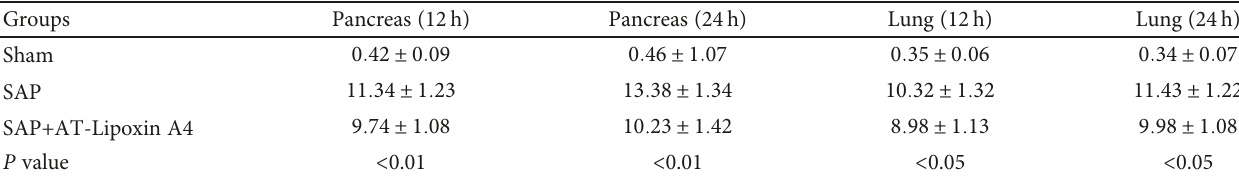
Figure 5: Attenuation of histopathological injury of the pancreas and lung in SAP model by AT-Lipoxin A4 administration. (a – f) H&E staining shows changes of the pancreas at 12h or 24 h after the procedure. (g – l) H&E staining shows changes of the lungs at 12 h or 24 h after the procedure. Table 2: Scores of pancreas and lung injuries ( n = 8